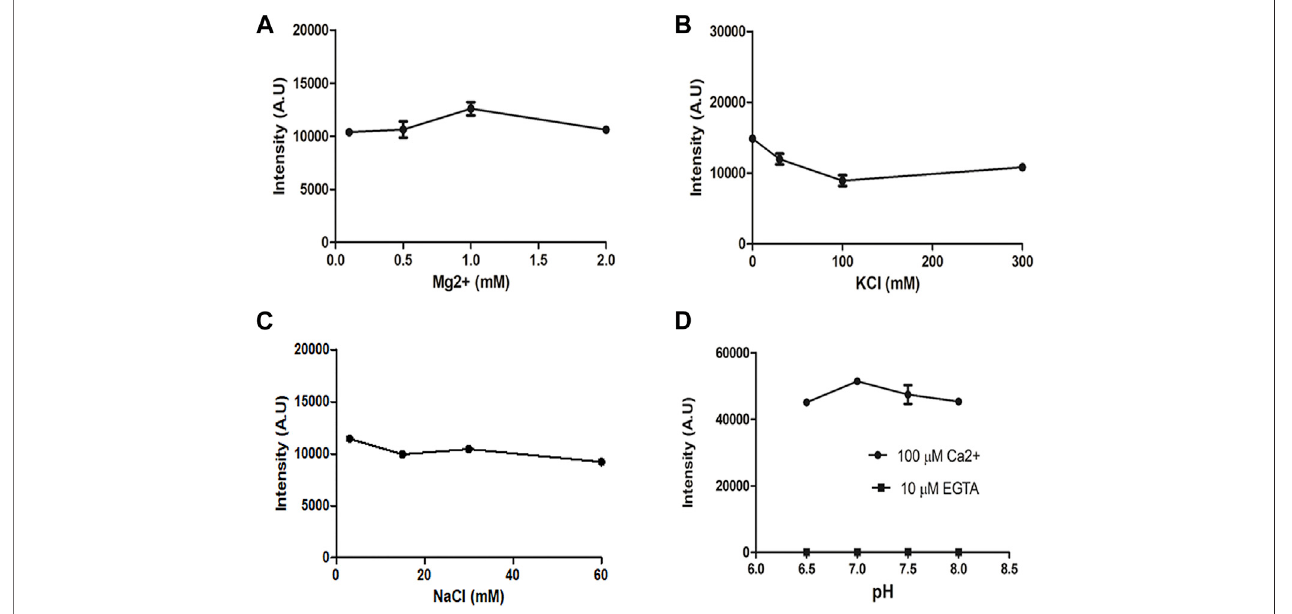
FIGURE 3 | Insensitivity of CalBiT2.0 to Mg, K + , Na + , and H + ions in vitro . CalBiT2.0 was puri fi ed using a 6-His tag and the intensity was recorded in solutions with increasing concentrations ofthe ions as shown. The data are plotted as intensity in response toincreasing [Mg ++ ] (A) ; [K + ] (B) ; [Na + ] (C) ; H + as pH (D) (mean ± standard deviations. n (cid:2) 3). ++